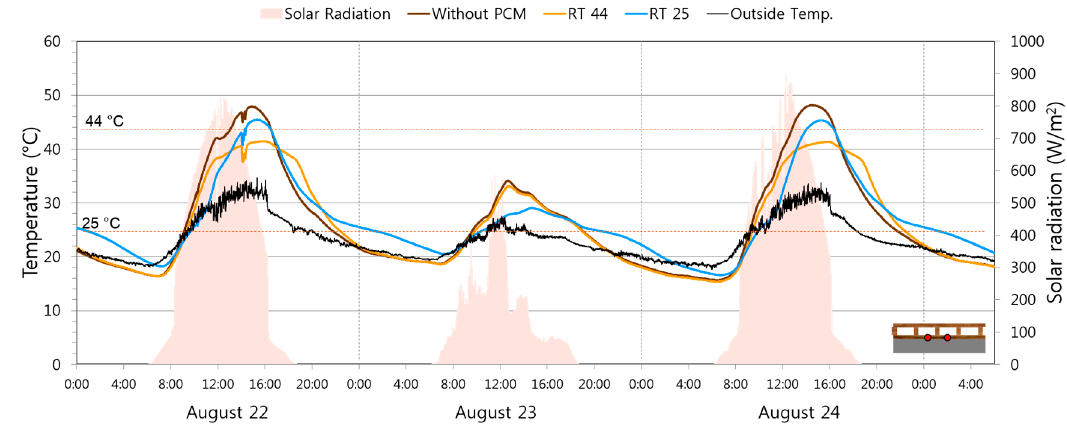
Figure 9. Bottom temperature of the plates with PCMs with different melting temperatures.